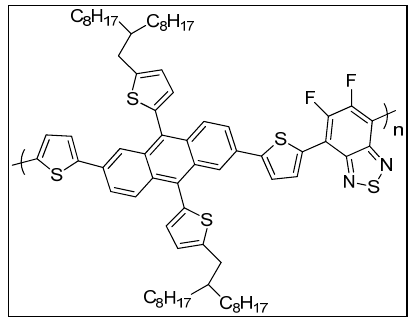
Figure 25. Molecular structure of PTADTDFBT.